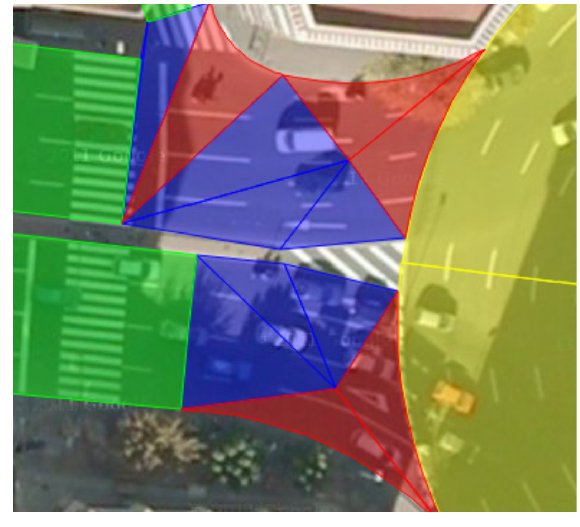
Figure 3. Superposition of some EEmap figures (in green, blue, red and yellow) over the roads of the city of Murcia,